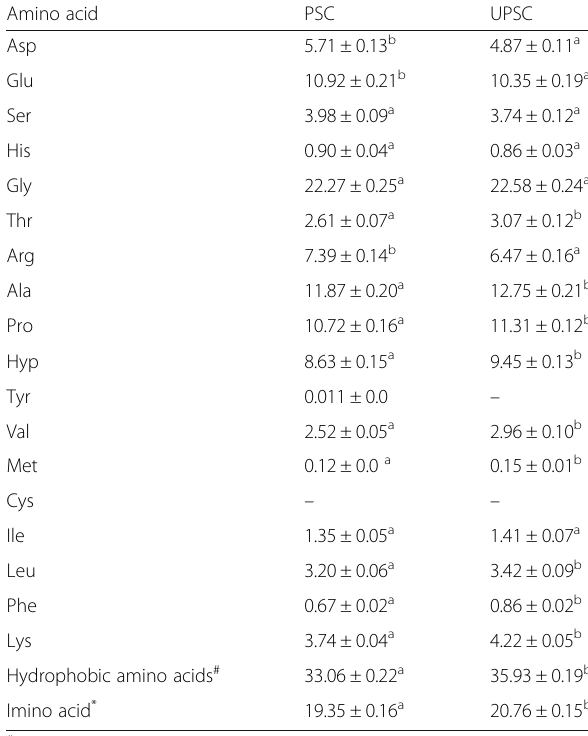
Table 2 Amino acid composition of PSC and UPSC from chicken lung (%, w/w) Amino acid